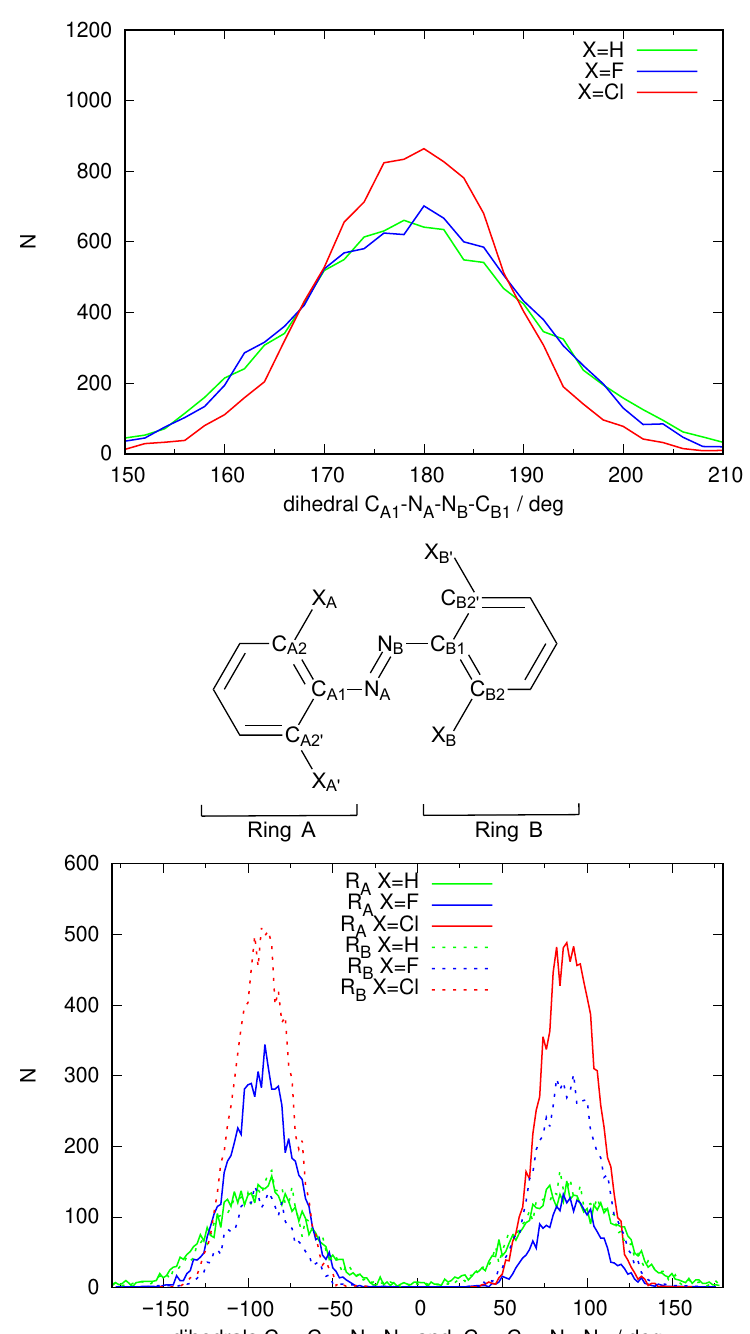
Figure 4. Distribution of the values of specific geometric parameters over the full MD simulations us- ing the GAFF2 force-field parameters used to construct the spectra for the three different azobenzene derivatives with X=H (azobenzene), F and Cl as shown in Figure 3. Labels of the atoms are defined on the structure in the center. Top: distribution of the dihedral defining the E - Z configuration of the N=N double bond; Bottom: distribution of the dihedral defining the inclination of the two phenyl rings with respect to the azo